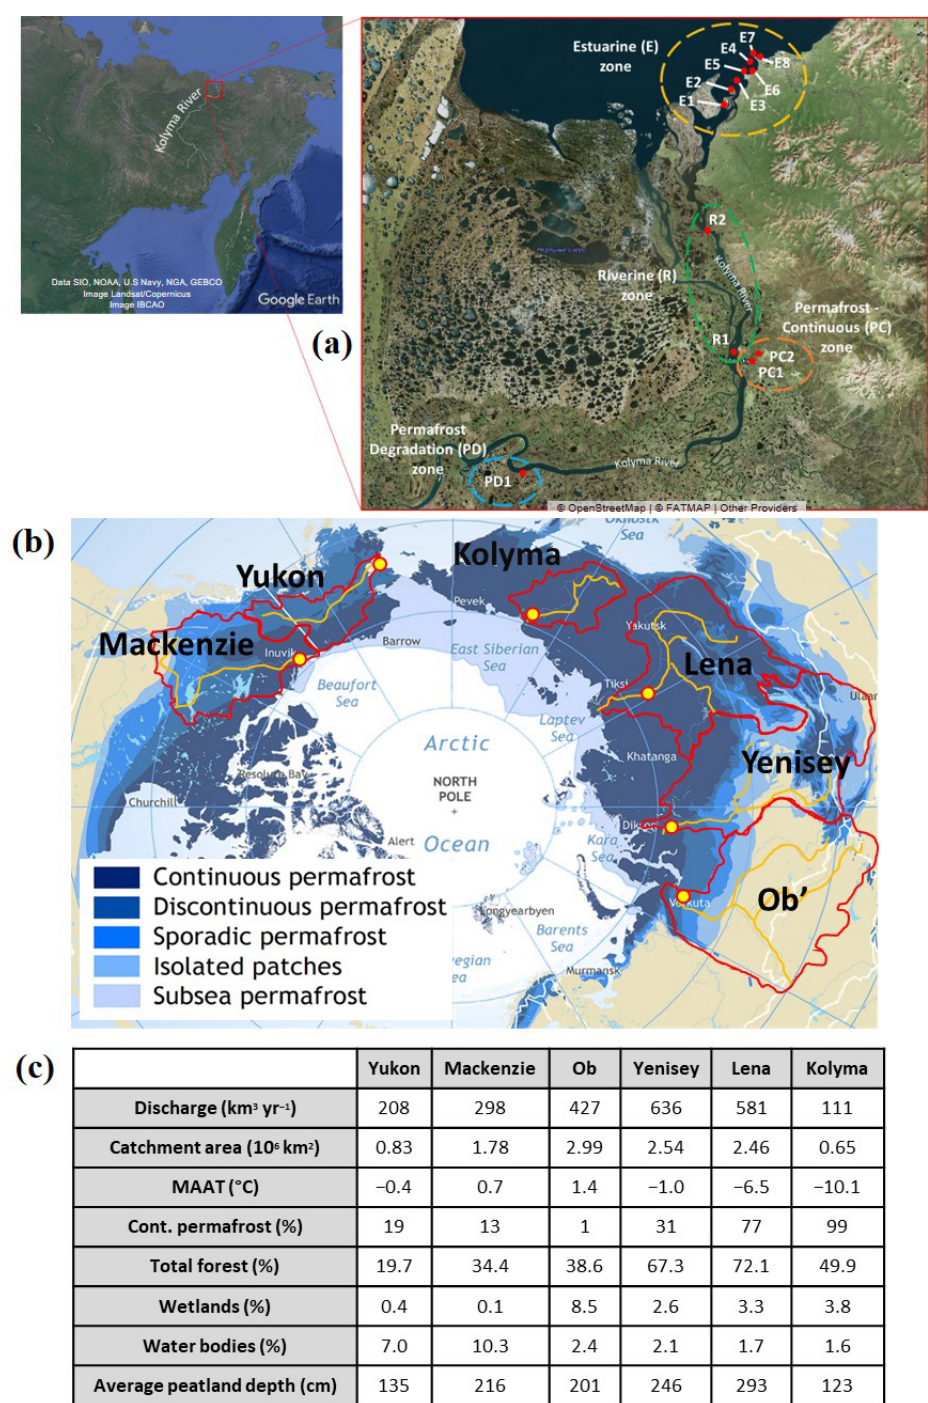
Figure 1. (a) Sample names and collection locations from sites around the lower Kolyma River and estuary. Samples collected on a research trip in autumn 2018. Satellite image 1 source: data SIO, NOAA, US Navy, NGA, GEBCO – image Landsat/Copernicus – image IBCAO © Google Earth. Satellite image 2 source: © OpenStreetMap – © FATMAP – other providers. (b) Catchment areas (red lines) and sampling locations (red and yellow circles) of the six largest Arctic rivers (orange lines) used in the ArcticGRO III (Arctic Great Rivers Observatory) project. The extent and type of permafrost present in each catchment is also shown. Base map modified from Brown et al. (1997). (c) Catch- ment characteristics of each river shown. Data taken from Amon et al. (2012) and Holmes et al. (2012), and average peatland depth calculated from supplementary data in Hugelius et al.